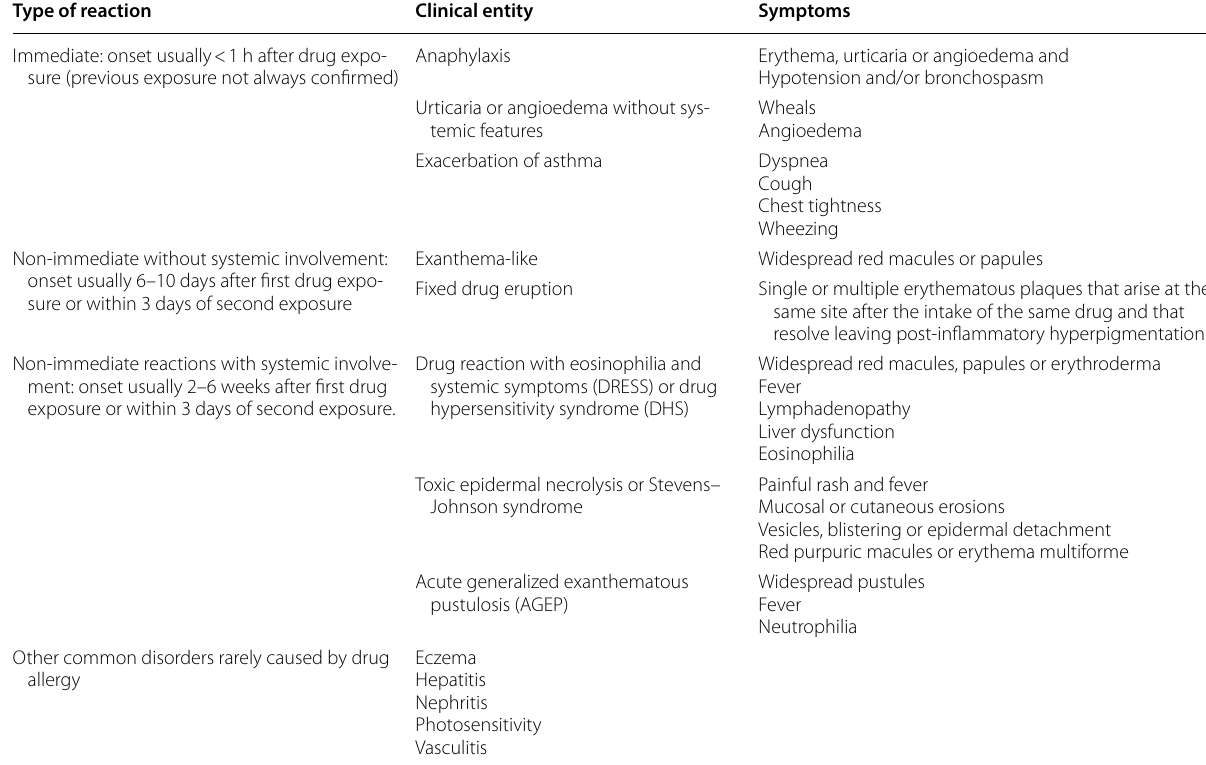
Table 1 Symptoms of the acute phase of the reactions induced by drugs Modified from the NICE Clinical Guideline